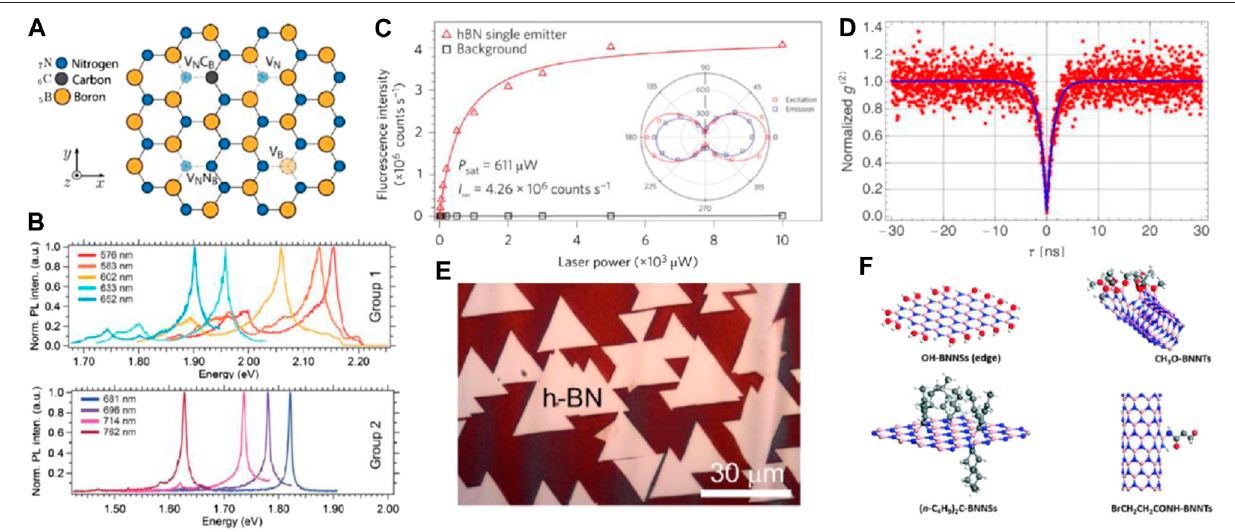
FIGURE1| Properties ofhexagonalboron-nitride. (A) Crystalline structure ofhBNand point defects consistingof(complexesof) vacancies and foreign atoms. (B) Multicolorphotoluminescencefrom pointdefects inhBN. (C) Photoluminescencesaturationcurve fromasingle hBNdefect (maximum emission rate4.26 × 10 6 counts/ s).Inset:excitation (red,circles) andemission(blue,squares)polarizationcurvesfromasinglehBNdefect. (D) Second-orderautocorrelationmeasurement g ( 2 ) ( τ (cid:2) 0 ) (cid:2) 0 . 033 ( 47 ) of a single hBN defect, indicating the quantum (single-photon emission) nature of the emitter (conventionally attributed for g ( 2 ) ( 0 ) < 0 . 5). (E) Optical imageofhBNgrownfor10 minoncopper foilbyatmosphericpressurechemicalvapordeposition(APCVD). (F)